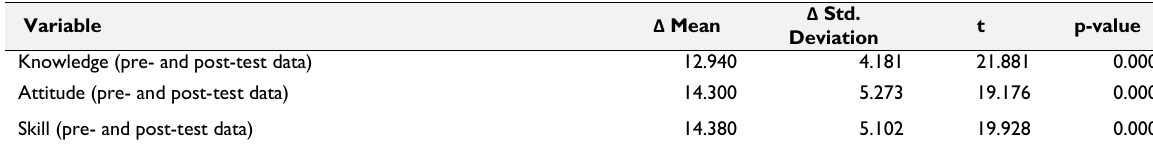
Table 3 Results of the pre- and post-data analysis competencies in detail BTCLS training of nurses in Dr. Soetomo Hospital Surabaya